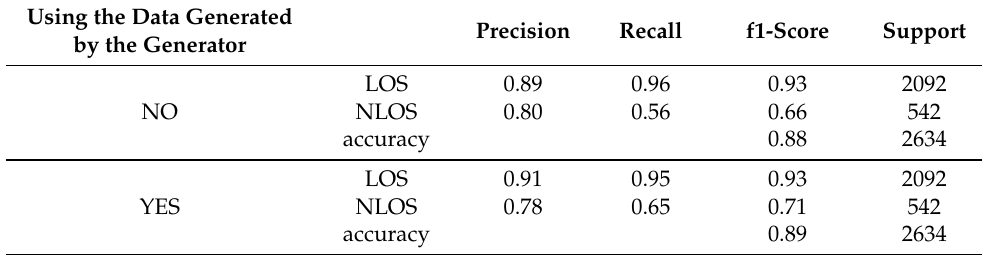
Figure 15. Variation of the discriminator loss function during the training. Table 4. Performance of our trained MLP models.